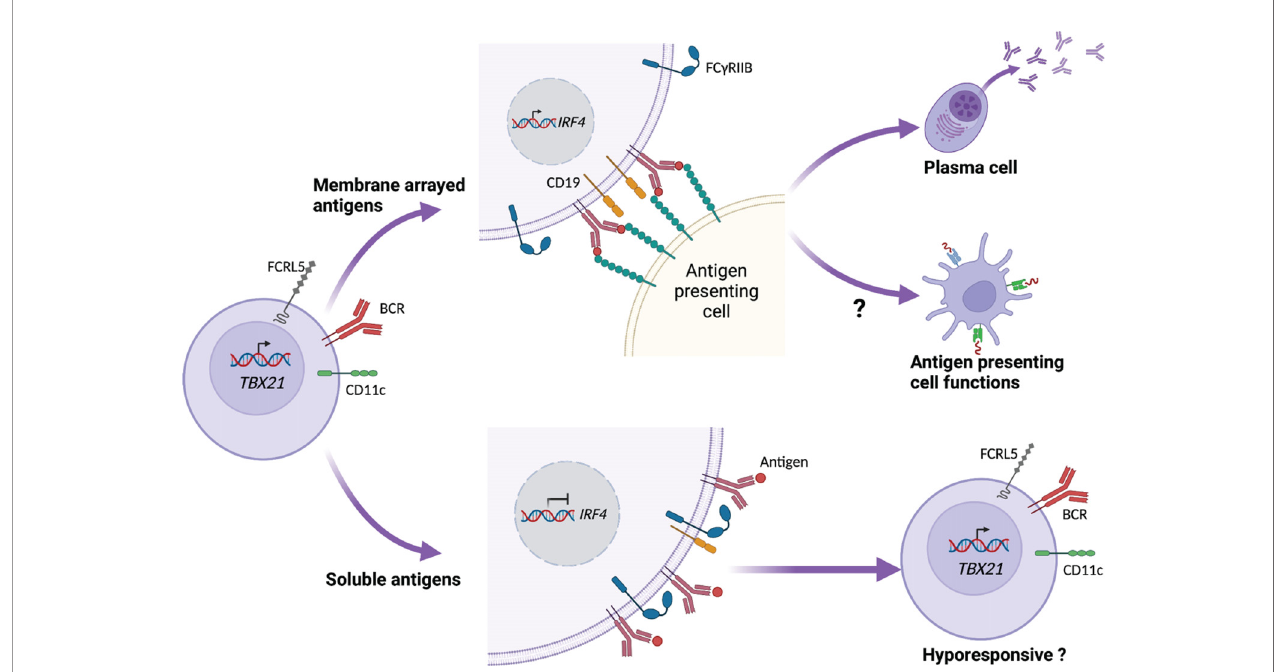
FIGURE 2 | CD21 lo B cell responsiveness is dependent on how antigen is presented. CD21 lo B cells expressing CD11c, T-bet ( TBX21 ), and FCRL5 also express increased levels of inhibitory receptors, such as Fc g RIIB. In the context of B cell receptor (BCR) ligation, Fc g RIIB reduces the engagement of CD19 with the BCR, thus preventing down stream signaling, leading to hyporesponsiveness. In contrast, CD21 lo B cells binding to membrane arrayed antigens establish an immunological synaps that excludes Fc g RIIB. This allows CD19 to engage the BCR and promote downstream signaling, leading to transcription of IRF4 that in turn can drive differentiation to antibody secreting cells. The membrane-arrayed antigens also lead to improved antigen-uptake and could potentially enhance the B cell antigen-presenting cell